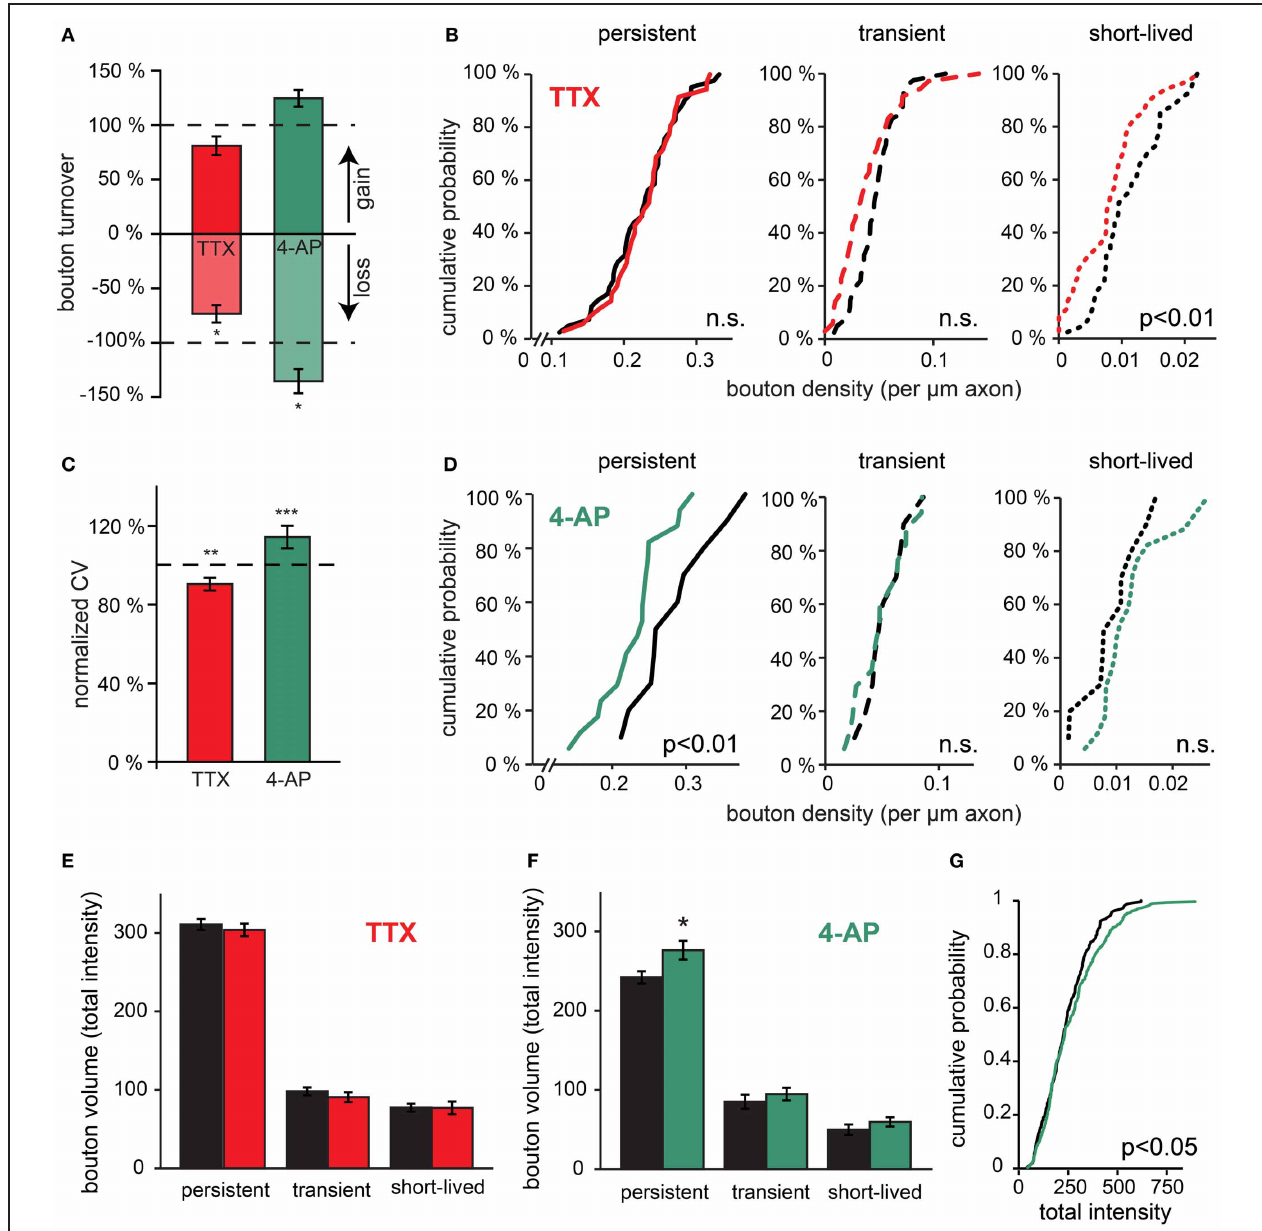
FIGURE 4 | Rapid effects of changes in network activity on bouton turnover. (A) Normalized bouton turnover of inhibitory axons during TTX and 4-AP treatment (averages per time point). Bouton turnover was defined as the fraction of boutons gained or lost between two consecutive imaging time points. Control values: bouton gain = 8 . 0 ± 0 . 2%, bouton loss = 8 . 7 ± 0 . 4%. (B) Cumulative distribution of the density of persistent, transient and short-lived boutons following TTX treatment. Data from 41 control and 34 TTX-treated axons (Student’s t -test). (C) Normalized coefficient of variation (CV) of bouton volume for persistent boutons during 4h of TTX and 4-AP